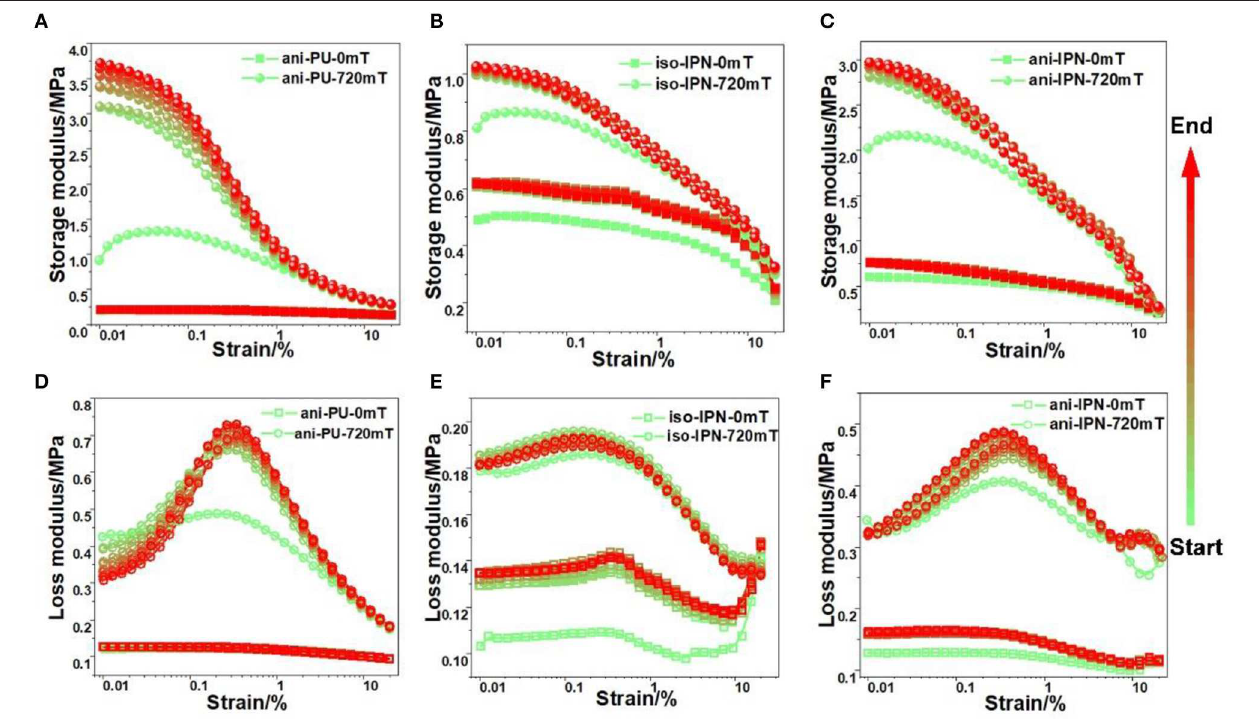
FIGURE 6 | The influence of the shear strain on the dynamic viscoelastic properties of MRE samples. Dependence of storage modulus of ani-PU sample (A) , ani-IPN sample (B) , and iso-IPN sample (C) on the shear strain in the absence and presence of magnetic field. Dependence of loss modulus of ani-PU sample (D) , ani-IPN sample (E) , and iso-IPN sample (F) on the shear strain in the absence and presence of magnetic field. The color scale indicates the progress of the cycle